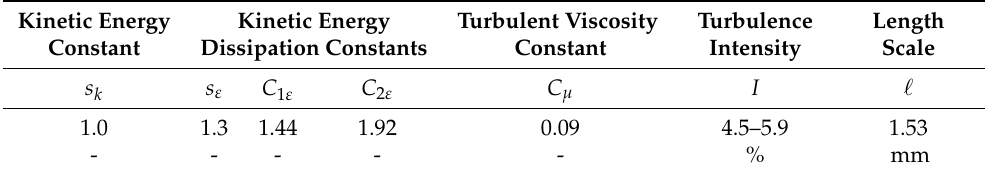
Table 2. Turbulence model parameters.